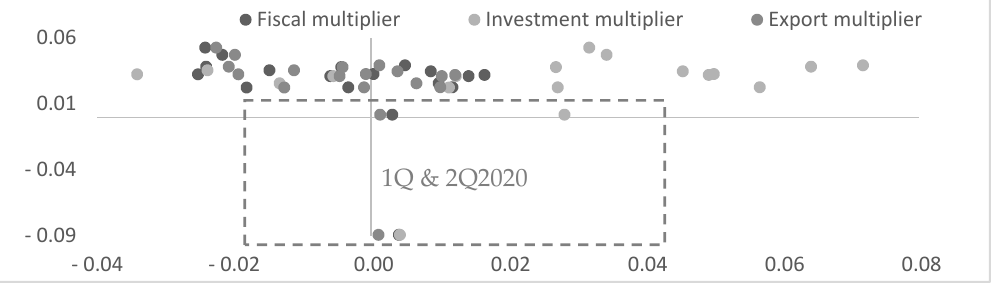
Figure 11. Correlation of changes in autonomous expenditure multipliers to GDP—Germany, own work, source: Eurostat.